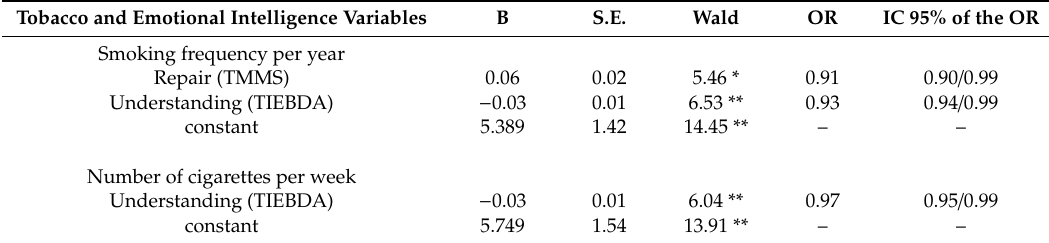
Table 5. Binary Logistic Regression of Tobacco Use as a Function of Trait and Ability EI for the 14–16-Year-Old Age Group. Tobacco and Emotional Intelligence